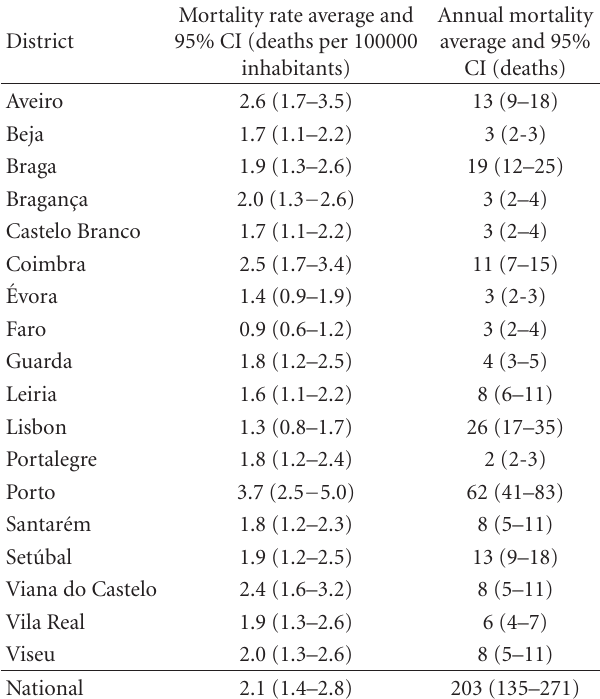
Table 1: Increase of mortality attributable to PM10 pollution levels under the climate scenario in comparison with the reference situa- tion. Values presented in parenthesis correspond to the 95% confi- dence interval (CI).